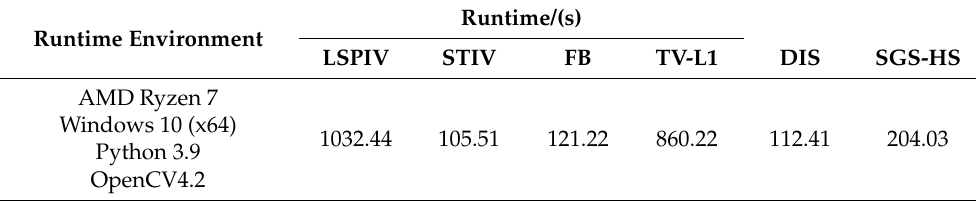
Table 5. Algorithm